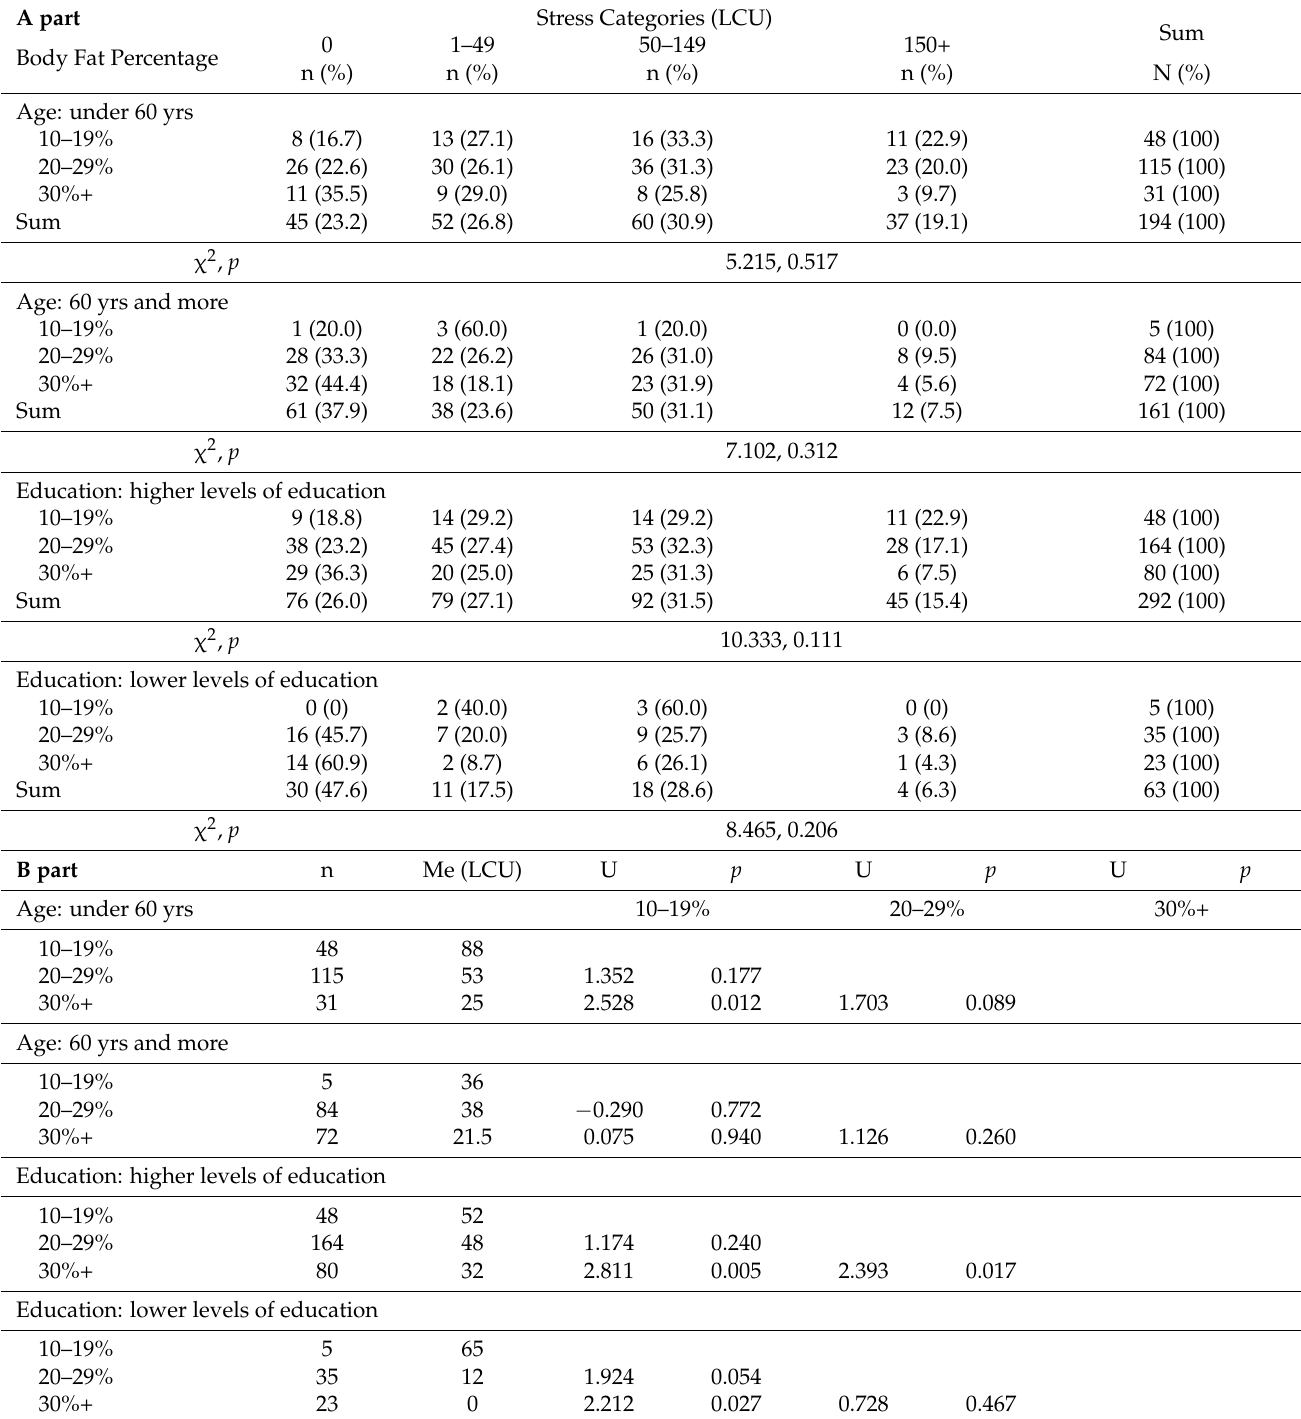
Table 4. Associations of stress with age and BFP category: Part A—number of observations (n) and proportions (%) of stress categories by age and Body Fat Percent category and results of χ 2 and p ; Part B—results of the Mann–Whitney U test for stress by age and BFP